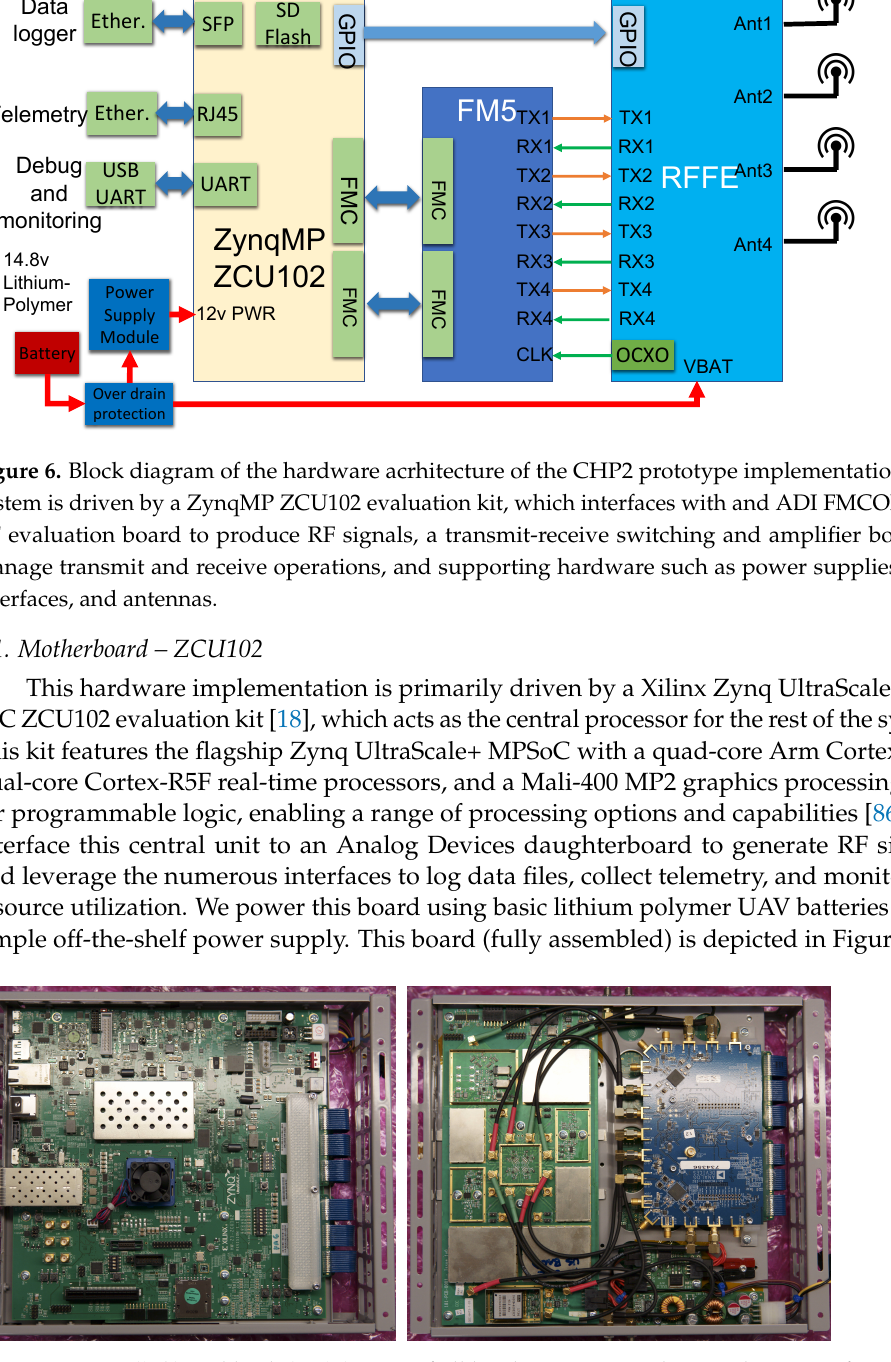
Figure 7. Front ( left ) and back ( right ) view of all hardware mounted in an aluminum frame. The front is the Xilinx ZCU102 evaluation board. The back contains the ADI transceiver card, the TR switching board, and the power supply